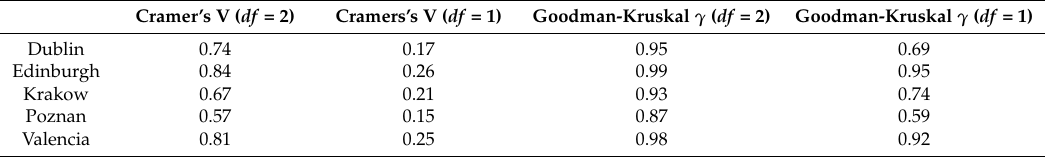
Table 4. Association between mobility and posting activity user types. Cramer’s V and Goodman-Kruskal γ were calculated for all user types ( df = 2) and for posting activity category limited to two classes ( df = 1)—see text for further